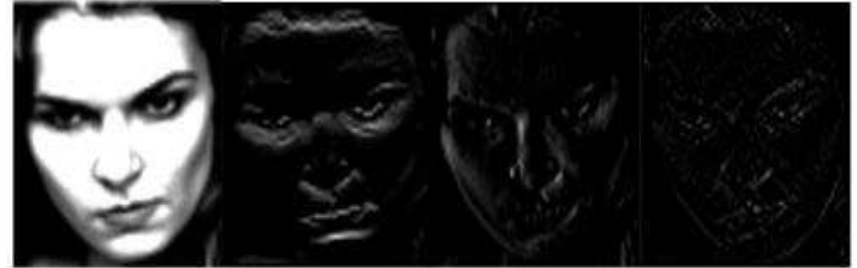
Figure 4. The illumination normalized expression samples of frequency domain transform based on DWT2 in RAF Compound. Approximate component, horizontal detail component, vertical detail component, diagonal detail component from left to right. Copyright reference: http://www.whdeng. cn/raf/model1.html#dataset.